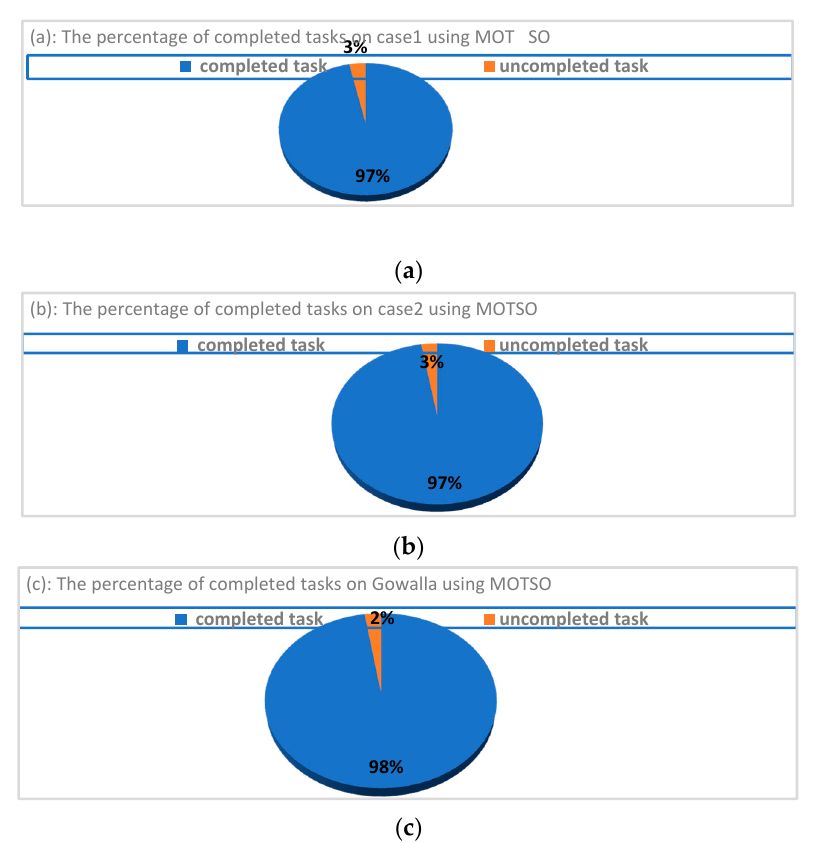
Figure 6. The percentages of completed tasks using the proposed MOTSO model for case 1 ( a ), case 2 ( b ), and Gowalla ( c ).